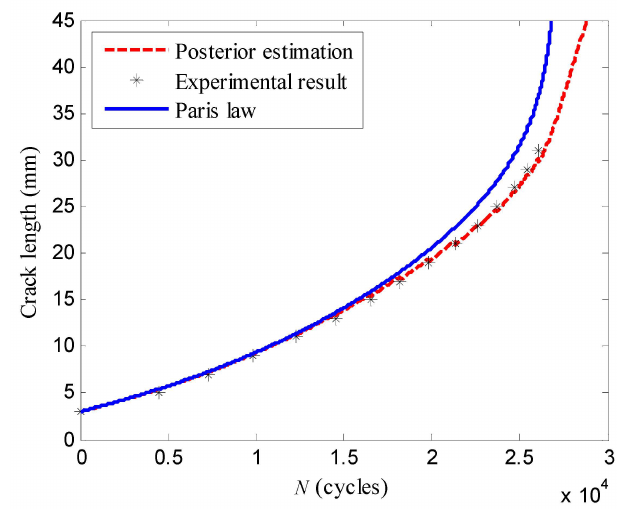
Figure 15. The posterior estimation of the specimen T 3 considering all the damage indices. Table 7. The posterior estimations of the crack length for the specimen T 3